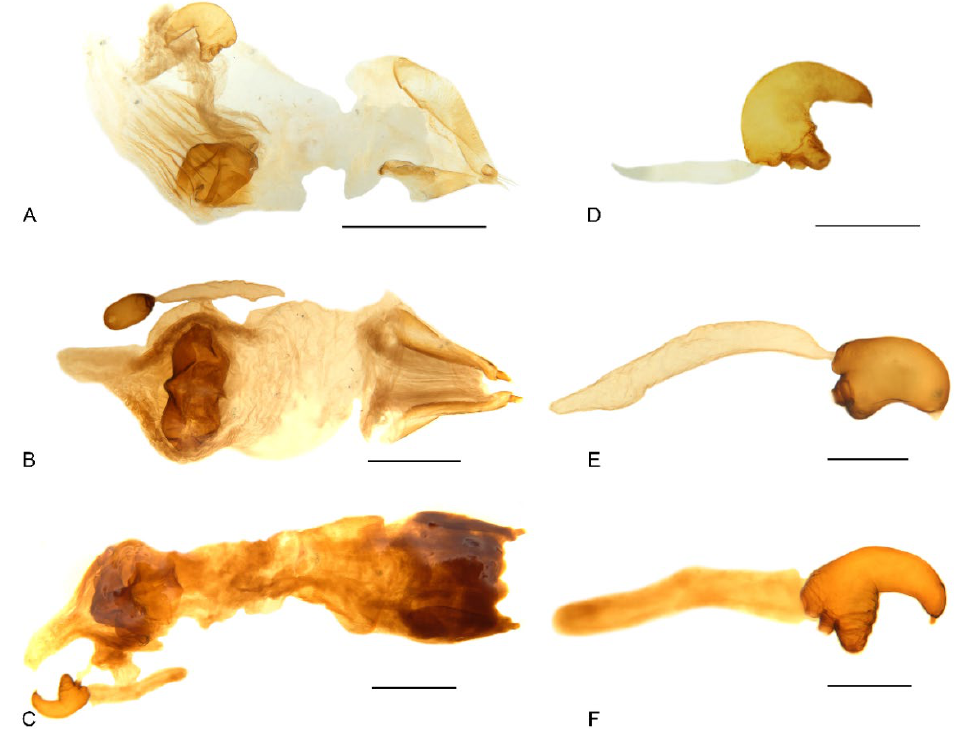
Figure 11. Female genital structures of Miltotranes : ( A ) M. prosternalis , genitalia; ( B ) M. subopacus , ditto; ( C ) M. wilsoni sp. n., ditto; ( D ) M. prosternalis , spermatheca with gland; ( E ) M. subopacus , ditto; ( F ) M. wilsoni sp. n., ditto. Scale bars: ( A , B ) 0.5 mm; ( D – F ) 0.2 mm. Larva. Body of nearly equal width throughout (Figure 12A), without black spinules on prodorsal fold, setae brown. Head reddish brown, free, without pale lines